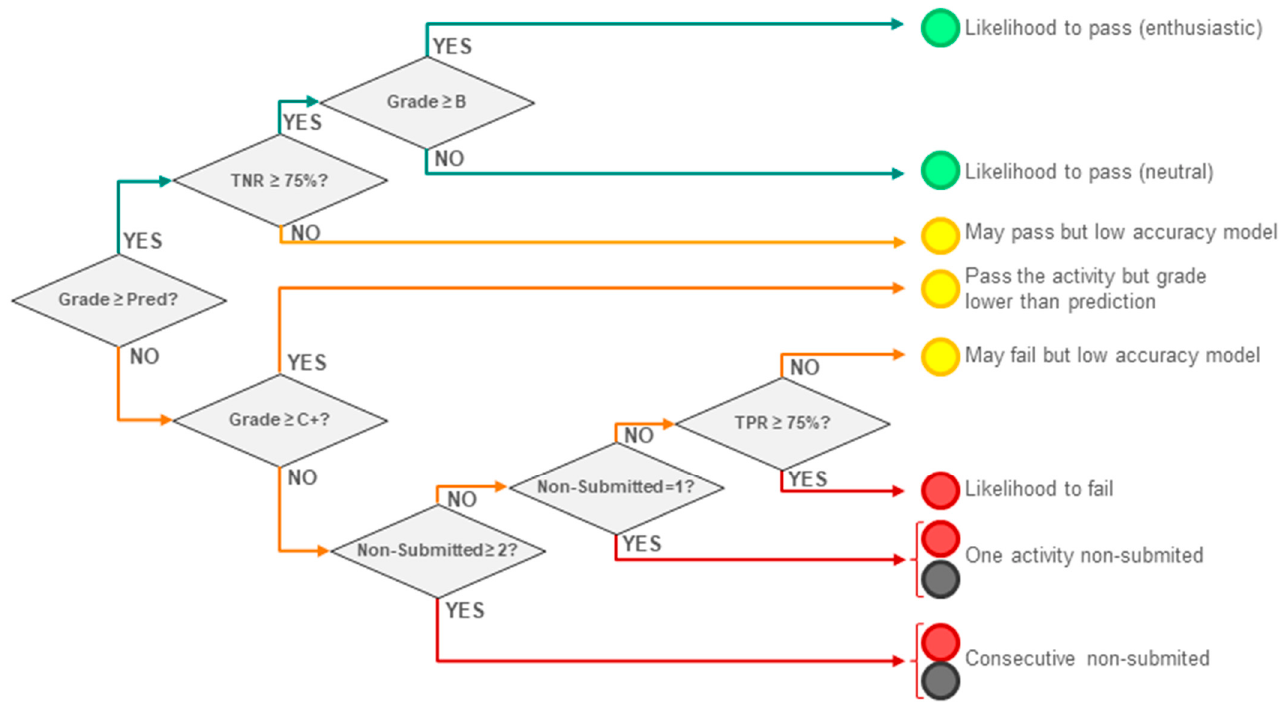
Figure 7. Decision tree for warning level classification.